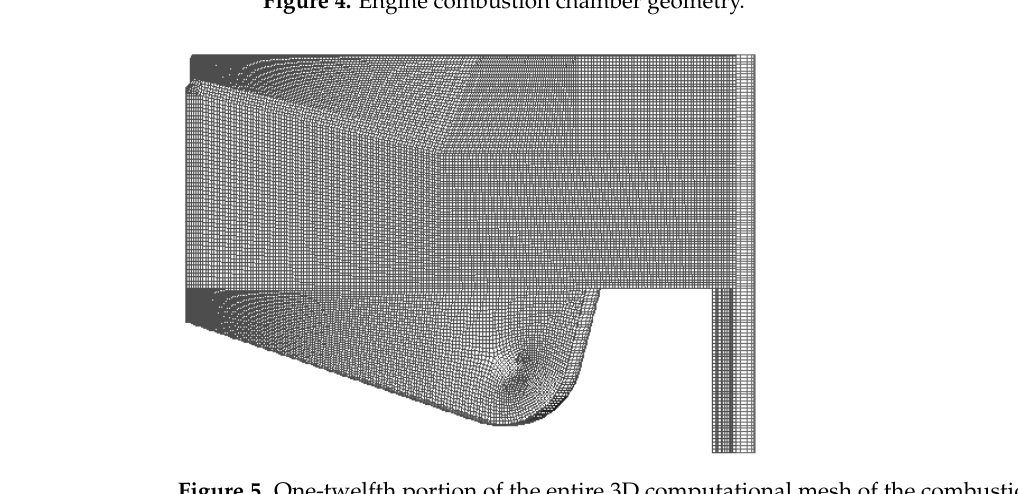
Figure 5. One-twelfth portion of the entire 3D computational mesh of the combustion chamber at 40 CAD ATDC. Table 3. Boundary conditions and initial conditions for the numerical simulation